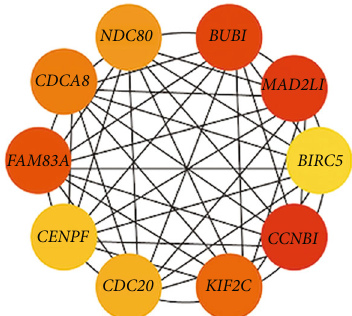
Figure 2: PPI networks of di ff erentially expressed genes associated with overall survival. Upload a list of di ff erentially expressed genes associated with overall survival to STRING, and set a reliability of 0.4 to determine whether the interaction is meaningful. The PPI network is